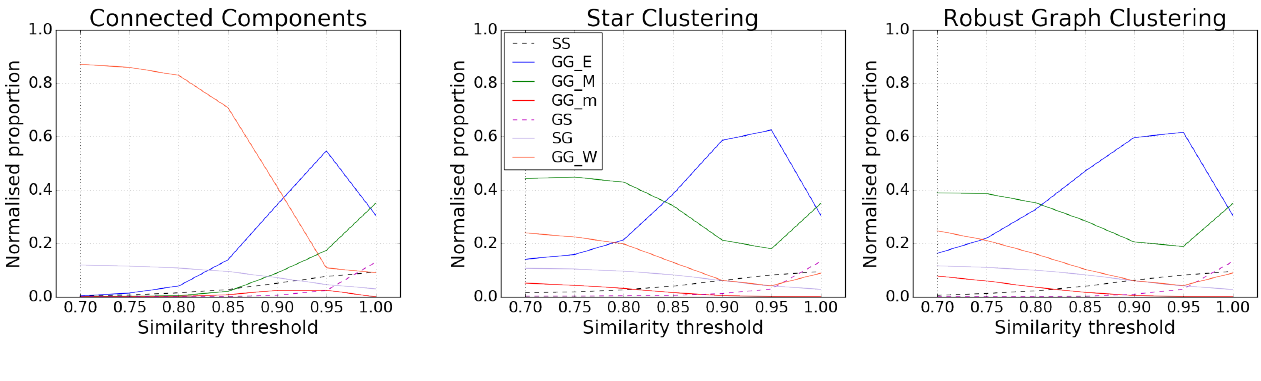
Figure 8: Plots for new evaluation results for the three clustering techniques (Names only attribute combination) .